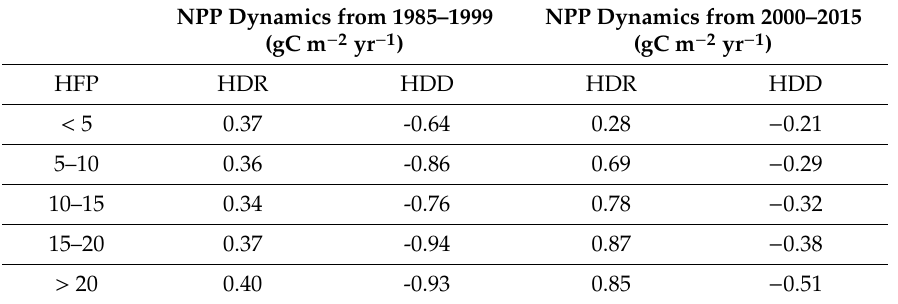
Table 6. E ff ect of human footprint pressure on NPP dynamics for the base and restoration